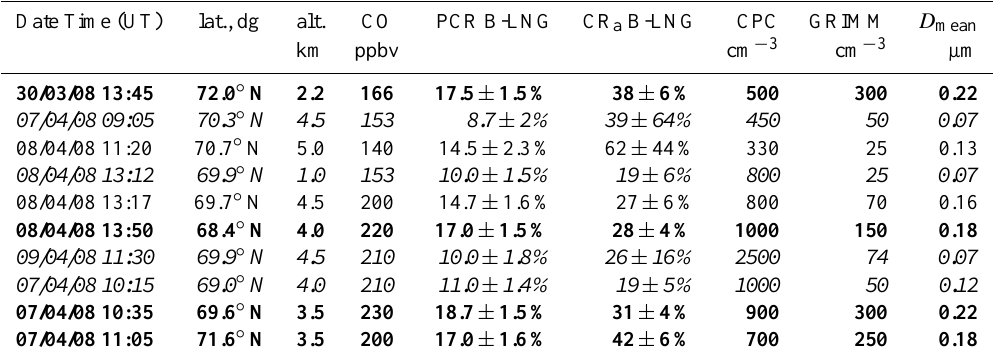
Figure 3. Left – comparison of B-LNG lidar attenuated backscatter averaged 120 to 200m below the aircraft in 2 . 5 × 10 − 5 km − 1 sr − 1 with in situ measurements of CO (red) in ppbv and condensation particle counter (CPC) aerosol concentration (black) in cm − 3 for the flight 35. The green curve is the aircraft altitude in 5m unit. Right – B-LNG lidar colour ratios (PCR and CR a ) in % for 10 aerosol layers where in situ and lidar data can be compared (see Table 2) versus the scanning mobility particle sizer (SMPS) aerosol mean diameter. Table 2. Comparison of mean aerosol layer pseudo-(PCR) and aerosol (CR a ) colour ratio measured by the B-LNG lidar and in situ measure- ments: CO mixing ratio, GRIMM integral and CPC concentrations and the mean aerosol diameter D mean from the SMPS+GRIMM spectrum. Layers data in italic or bold are respectively for low or high value colour